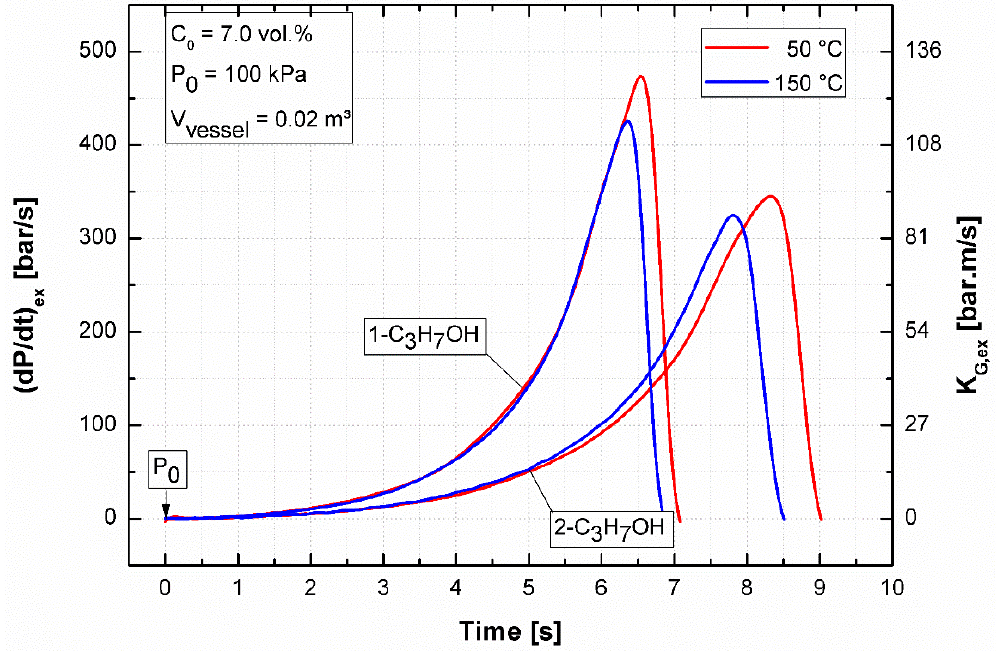
Figure 5. (dp/dt) max /time for 1-propanol and 2-propanol deflagration in a 0.02 m 3 chamber, p 0 = 100 kPa.